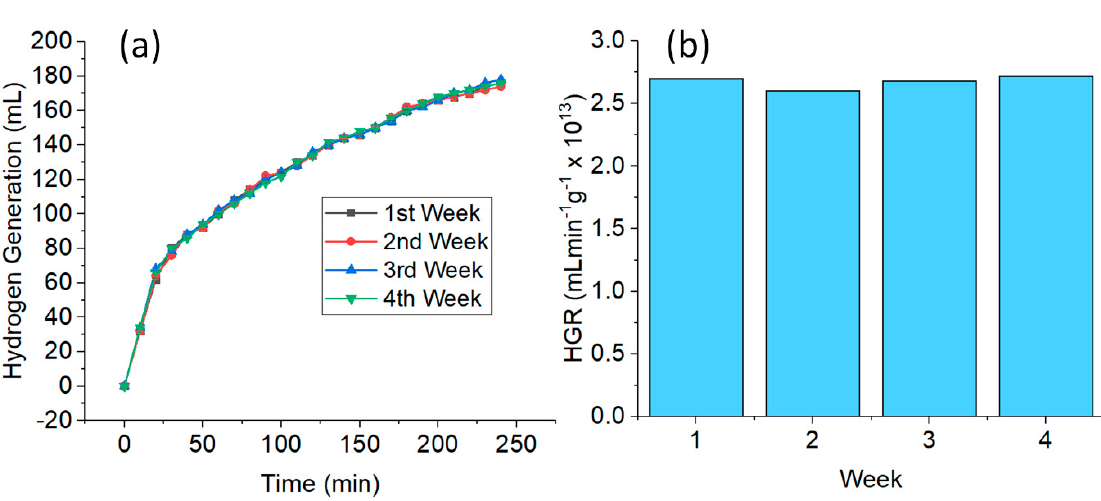
Figure 6. Plot of ( a ) H 2 generation versus time; and ( b ) HGR of the hydrolysis of NaBH 4 of the CuNWs strips for four weeks (conditions: CuNWs = 0.1 ng, 10 mL of [NaBH 4 ] = 1 wt%, pH = 12, and temperature = 298 K).